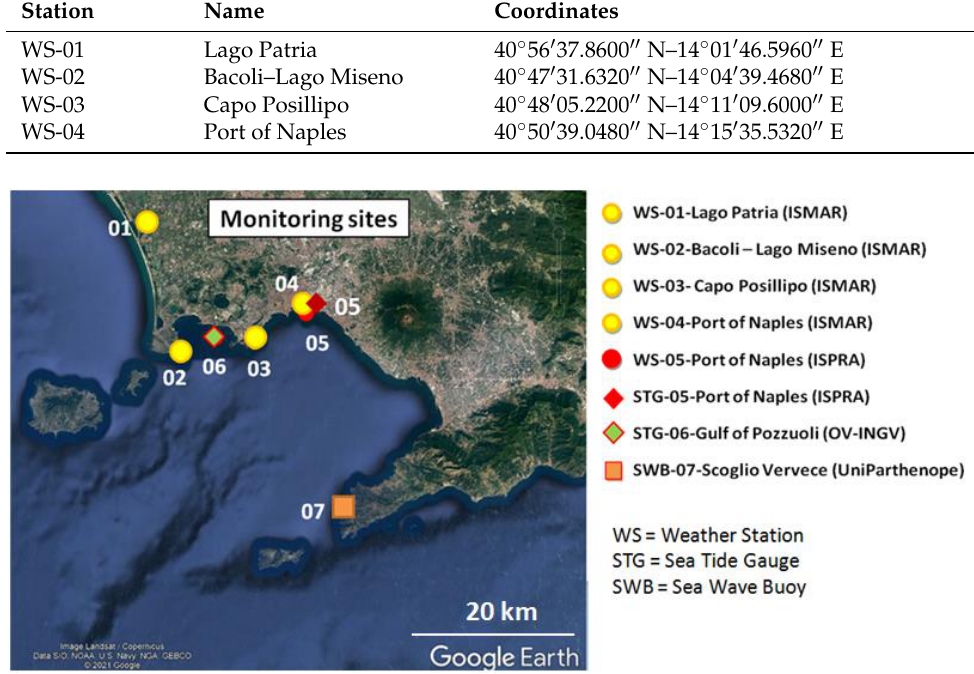
Figure 2. Location of the weather stations used in this study. Monitoring sites are managed by various research institutions: ISMAR (Consiglio Nazionale delle Ricerche, Istituto di